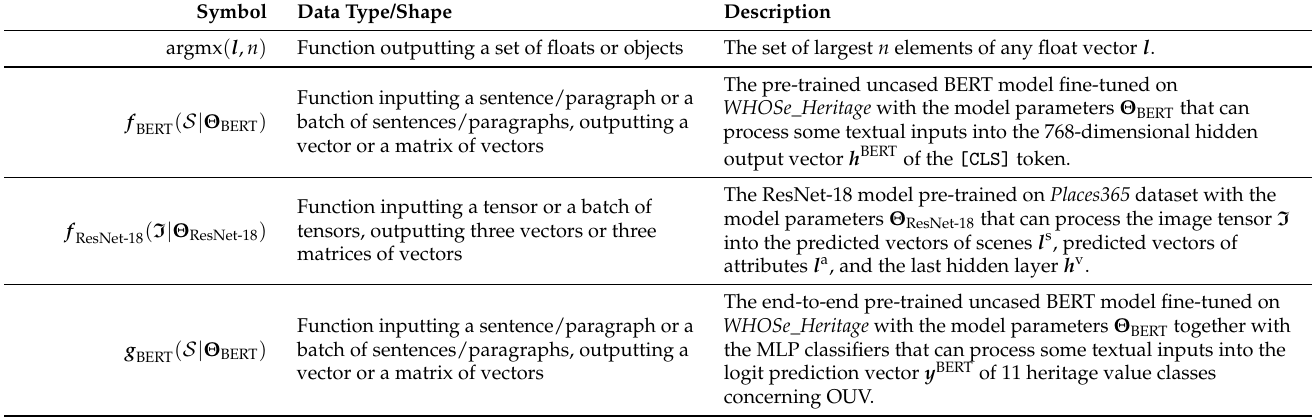
Table A2. The nomenclature of functions defined and used in this paper in alphabetic